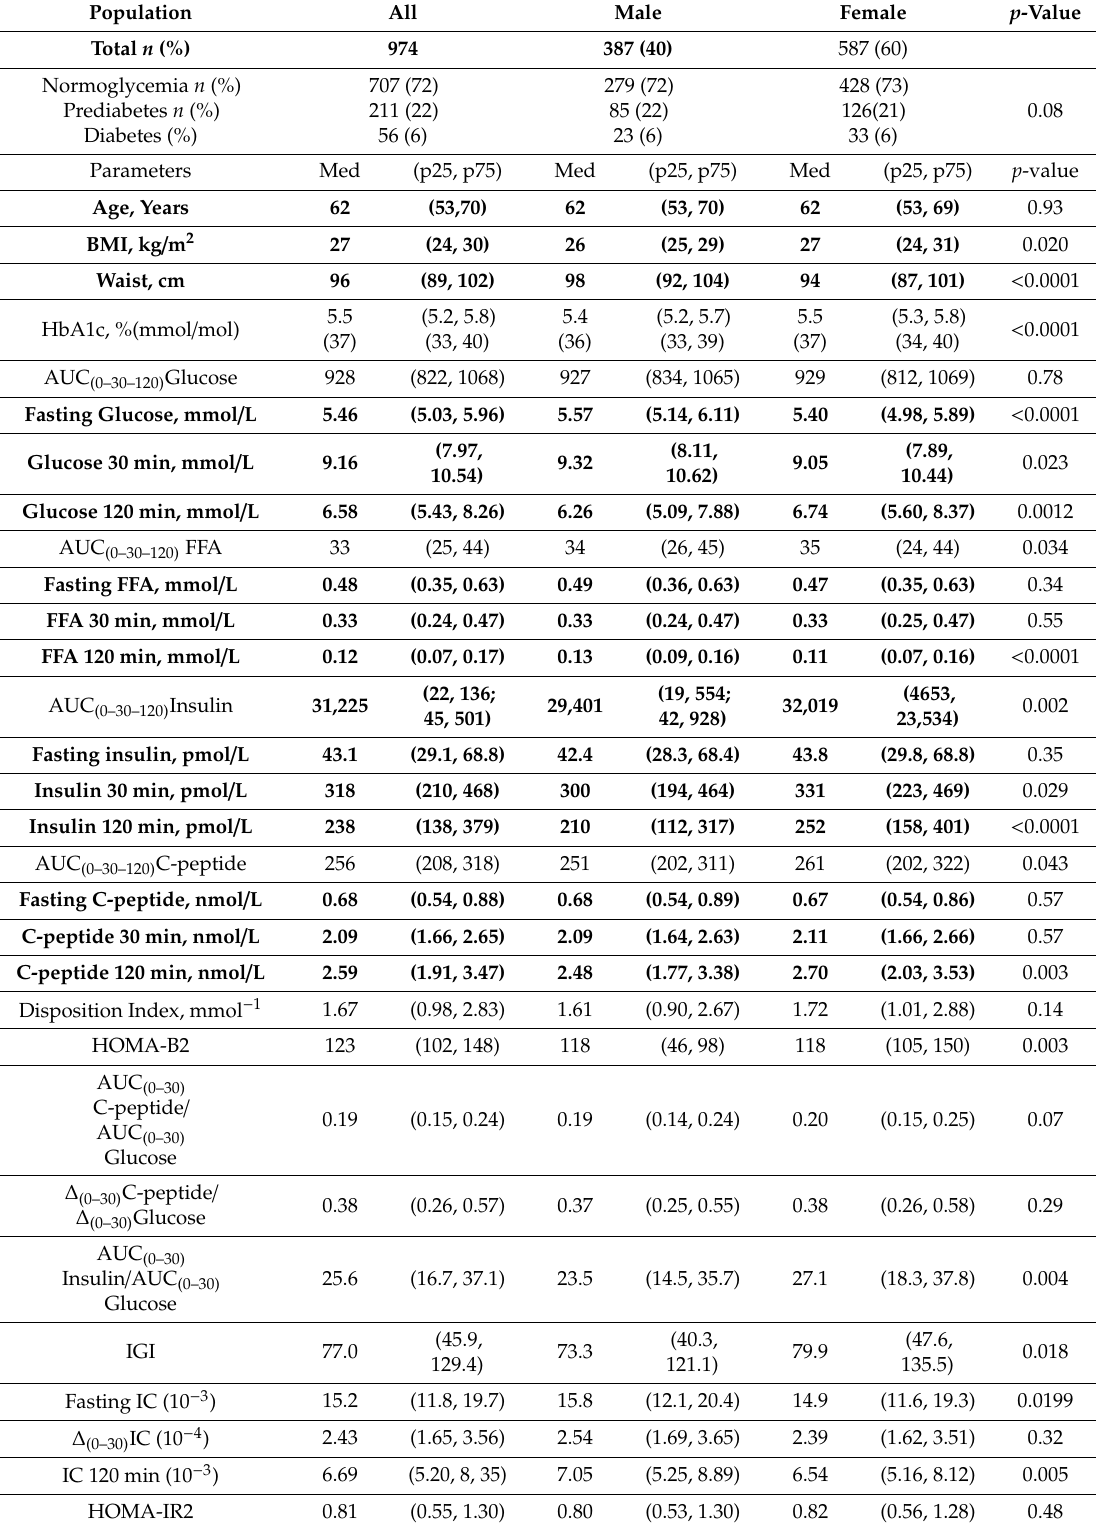
Table 1. Summary statistics of the population reported as median and (p25, p75) for continuous variables and as percentages for categorical variables. Parameters informing the cluster algorithm are in bold, the remaining parameters were used for cluster profiling. Comparison between genders was performed with Mann–Whitney test for continuous variables and with chi-square test for categorical